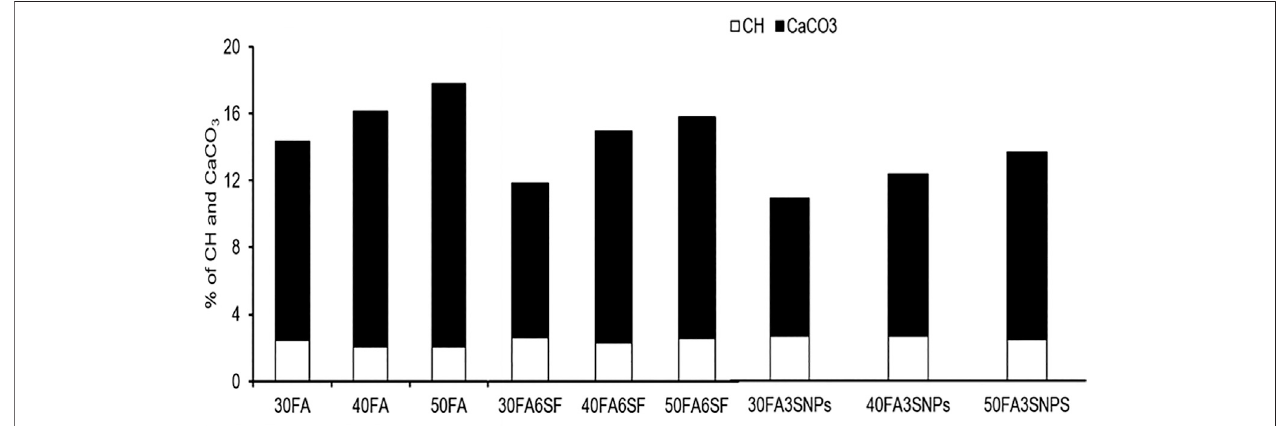
FIGURE 7 | Quanti fi cation of CH and CaCO 3 content in 30%, 40%, and 50% of fl y ash containing 3% SNPs and 6% SF mixes by thermogravimetric analysis after 365 days of exposure.